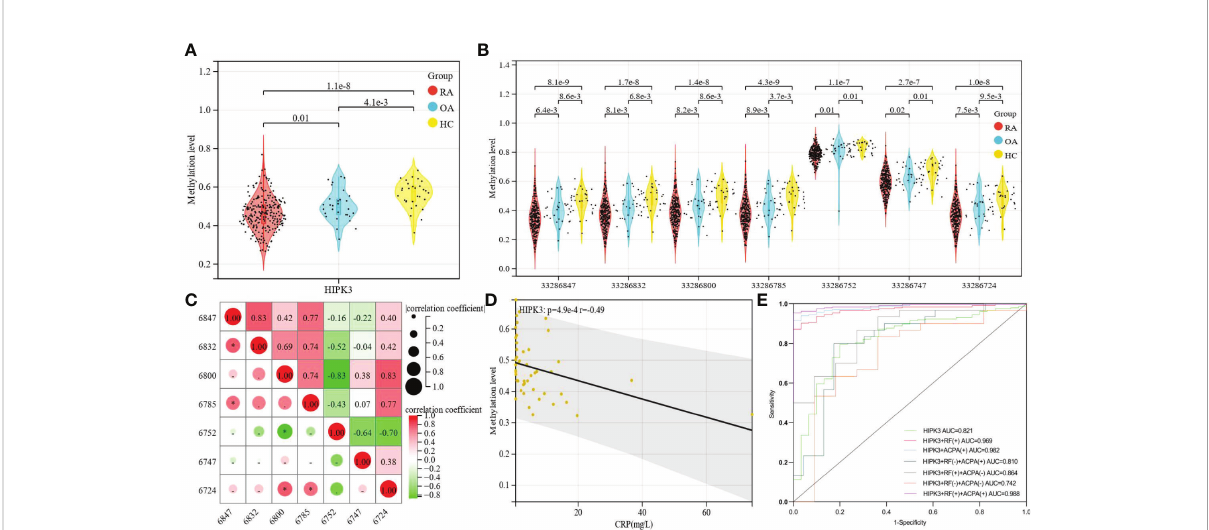
FIGURE 1 Differences in methylation level and correlation of HIPK3. (A) , Methylation level of HIPK3 between RA, OA patients and healthy controls; The result found that the methylation level of HIPK3 was down-regulated in patients with RA (P= 1.143×10 -8 ). (B) , Methylation level of seven CpGs in different patients; Further analysis showed that HIPK3 has seven CpGs, including 33286847, 33286832, 33286800, 33286785, 33286752, 33286747, and 33286724; The difference analysis showed that the methylation levels of these CpGs in patients with RA were down-regulated, and the statistical difference of 33286785 is the most signi fi cant. (C) , Correlation analysis in different CpGs; The association analysis among seven CpGs showed that 6847 and 6832, 6800 and 6752 have strong correlation (|r|>0.8), and 6847 and 6785, 6832 and 6785, 6800 and 6785, 6724 and 6785, 6752 and 6724 have weak correlation. In general, there is a relatively close relationship between these CpGs. (D) , Correlation between HIPK3 and CRP in patients with 2.6 ≤ DAS28-CRP ≤ 3.2; In patients with 2.6 ≤ DAS28-CRP ≤ 3.2, there was a stronger correlation between HIPK3 and CRP (r= -0.49, p= 0.00049), indicating that HIPK3 has a higher clinical value in predicting CRP levels in these patients. (E) Multi-factor joint ROC analysis of HIPK3 combined with RF and ACPA; In multi-factor joint analysis, the results showed that compare with RF/ ACPA, HIPK3 has more valuable clinical diagnostic signi fi cance in patients with RF (-)/ACPA (-) (AUC=0.742 vs 0.023). In addition, in patients with RF (+)/ACPA (+), adding the detection of HIPK3 methylation level was helpful to improve the diagnosis of RA (AUC=0.988), and HIPK3 could assist RF/ACPA as a new clinical index for the diagnosis of RA. *: P<0.05.